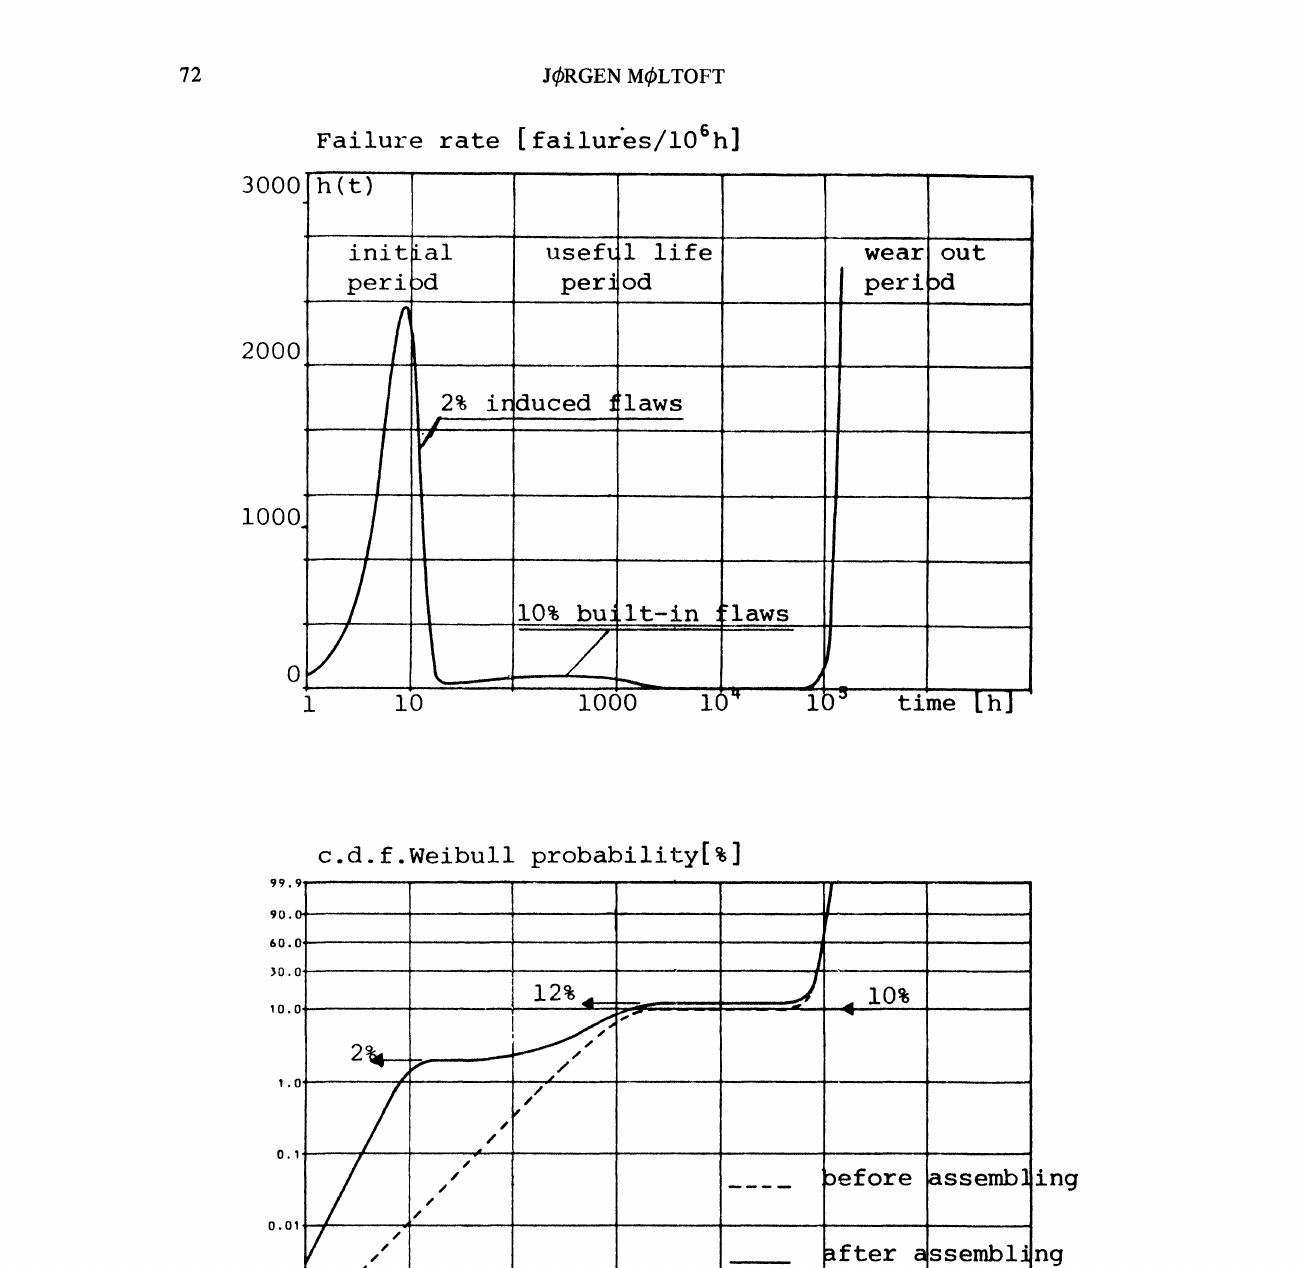
The failure patterns for a component type with a trimodal failure distribution